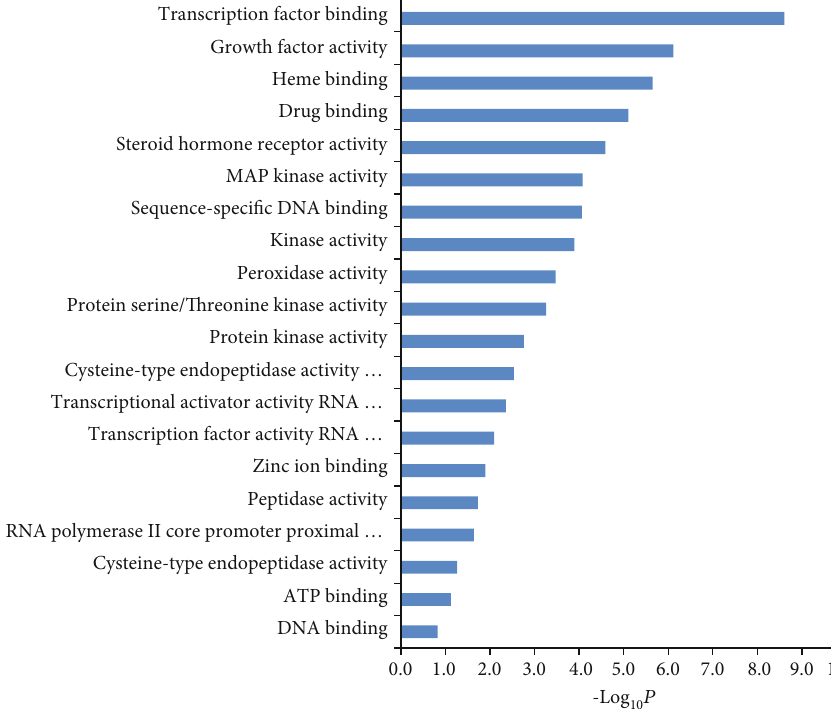
Figure 7: Enriched Gene Ontology (GO) terms for molecular function (MF) were analyzed by DAVID system under the condition with P value < 0.05.